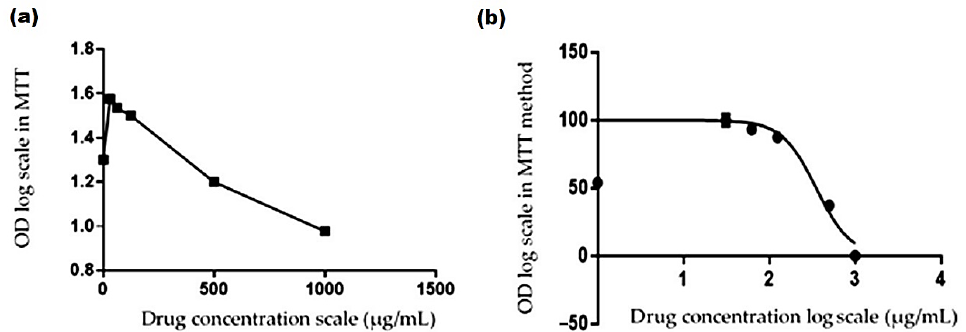
Figure 5. Dose-response curves of R. vesicarius extract in inhibiting the cell growth as a percentage of the control against HepG2 cell lines. ( a ) Transformation of the extracted R. vesicarius . ( b ) Normalization of the transformation of R. vesicarius extract. OD is the absorbance value at specific concentrations of the tested plant extract.